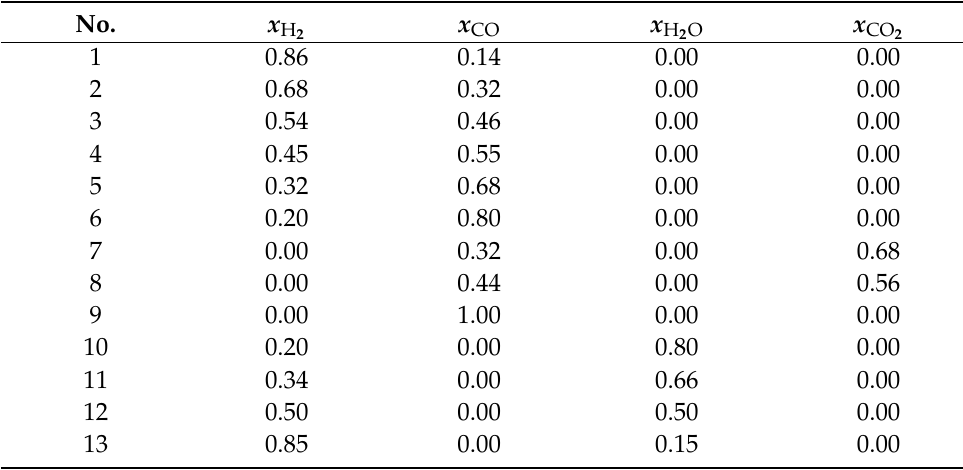
Table 1. Fuel mixture compositions in mole fractions of gaseous